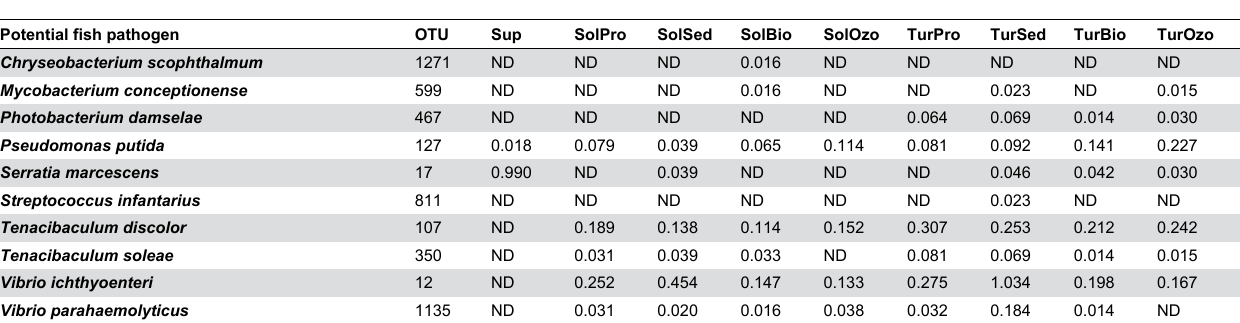
Table 3. Values of relative abundance (%) of potential fish pathogens detected in water supply (Sup), turbot production tank (TurPro), turbot sedimentation tank (TurSed), turbot biofilter tank (TurBio), turbot ozone tank (TurOzo), sole production tank (SolPro), sole sedimentation tank (SolSed), sole biofilter tank (SolBio), sole ozone tank